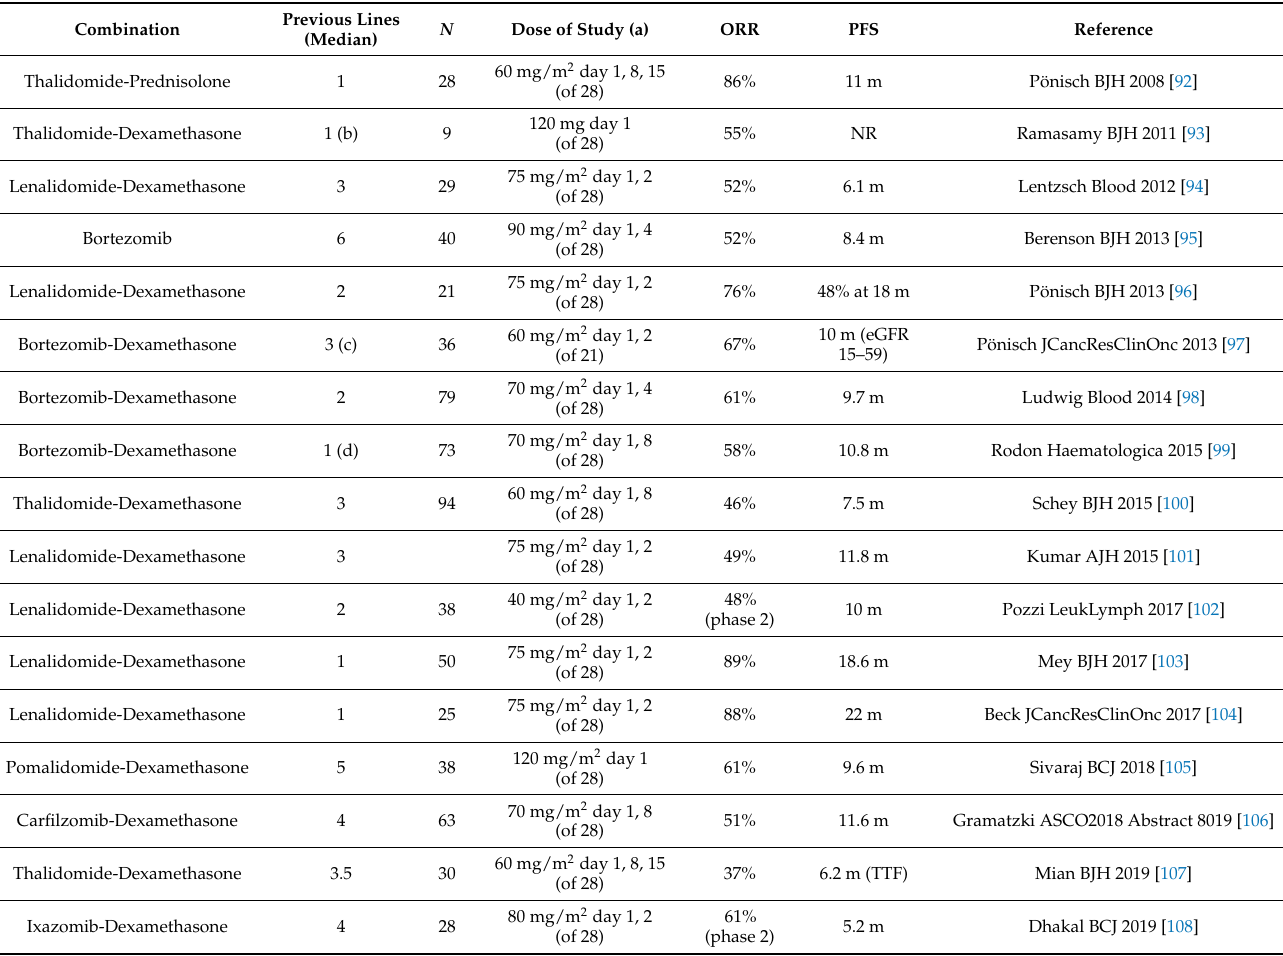
Table 1. Combination studies using bendamustine in the relapsed/refractory multiple myeloma setting. Combination Previous Lines (Median) N Dose of Study (a) ORR PFS